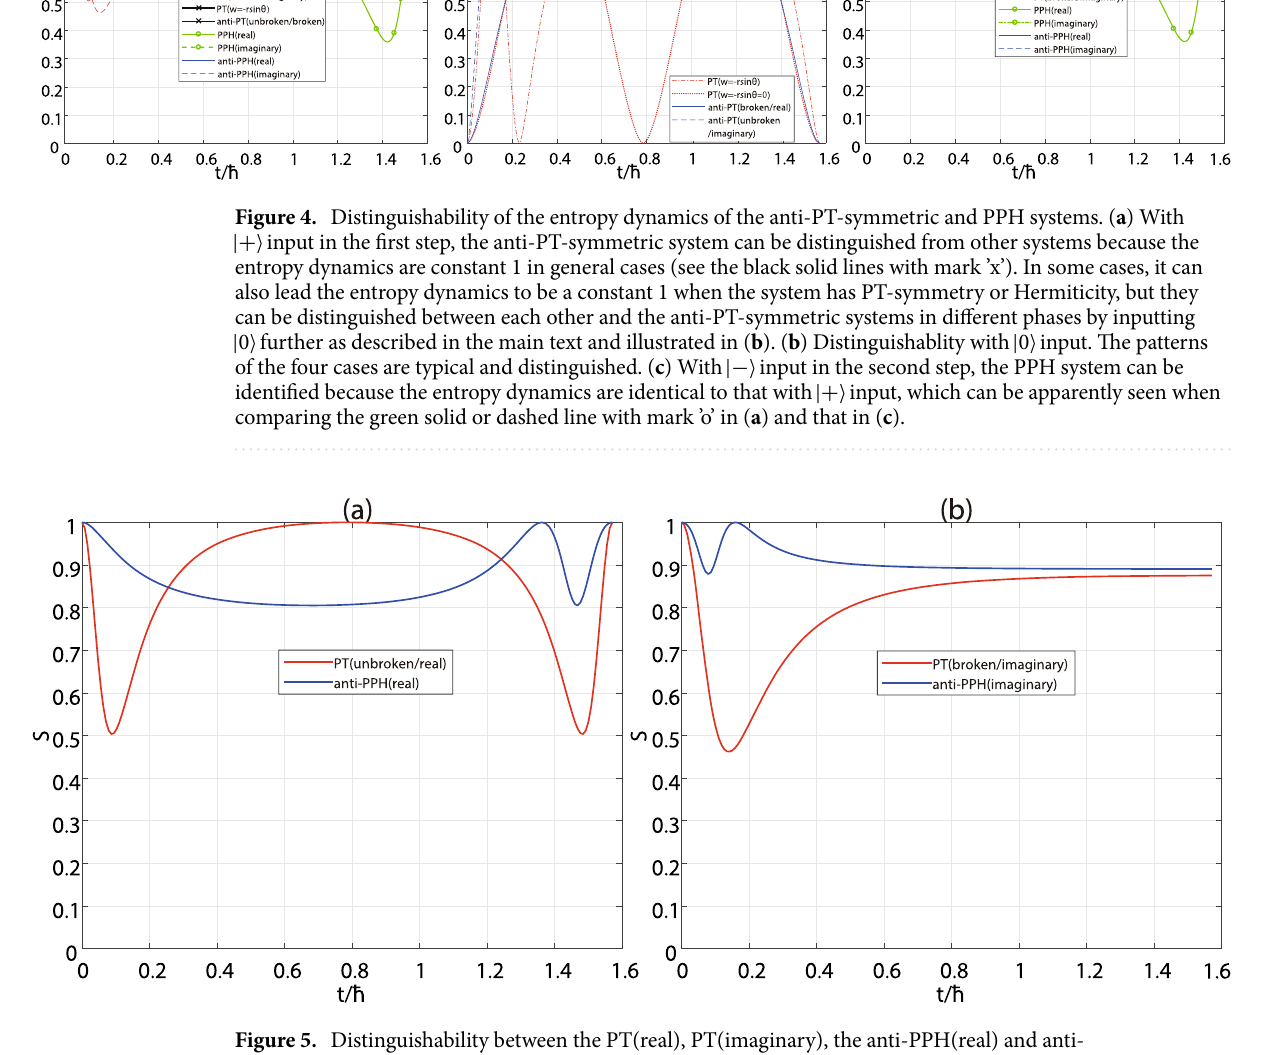
Figure 5. Distinguishability between the PT(real), PT(imaginary), the anti-PPH(real) and anti- PPH(imaginary) phases with |+� . ( a ) The PT-symmetric system in unbroken or PT(real) phase is relevant to the red line, while the anti-P-pseudo Hermitian system in anti-PPH(real) phase is relevant to the blue line. Both of the entropy patterns have period T and only one period are drawn here. But only the former one is of even symmetry at t = T / 2 . ( b ) The PT-symmetric system in broken or PT(imaginary) phase is relevant to the red line, while the anti-P-pseudo Hermitian system in anti-PPH(imaginary) phase is relevant to the blue line. The two curves have no period but they are approaching to their respective asymptotes as the time tends to the infinite. They are distinguishable because the PT(imaginary) increasingly approaches to its asymptote, whereas the anti-PPH(imaginary) decreasingly approaches